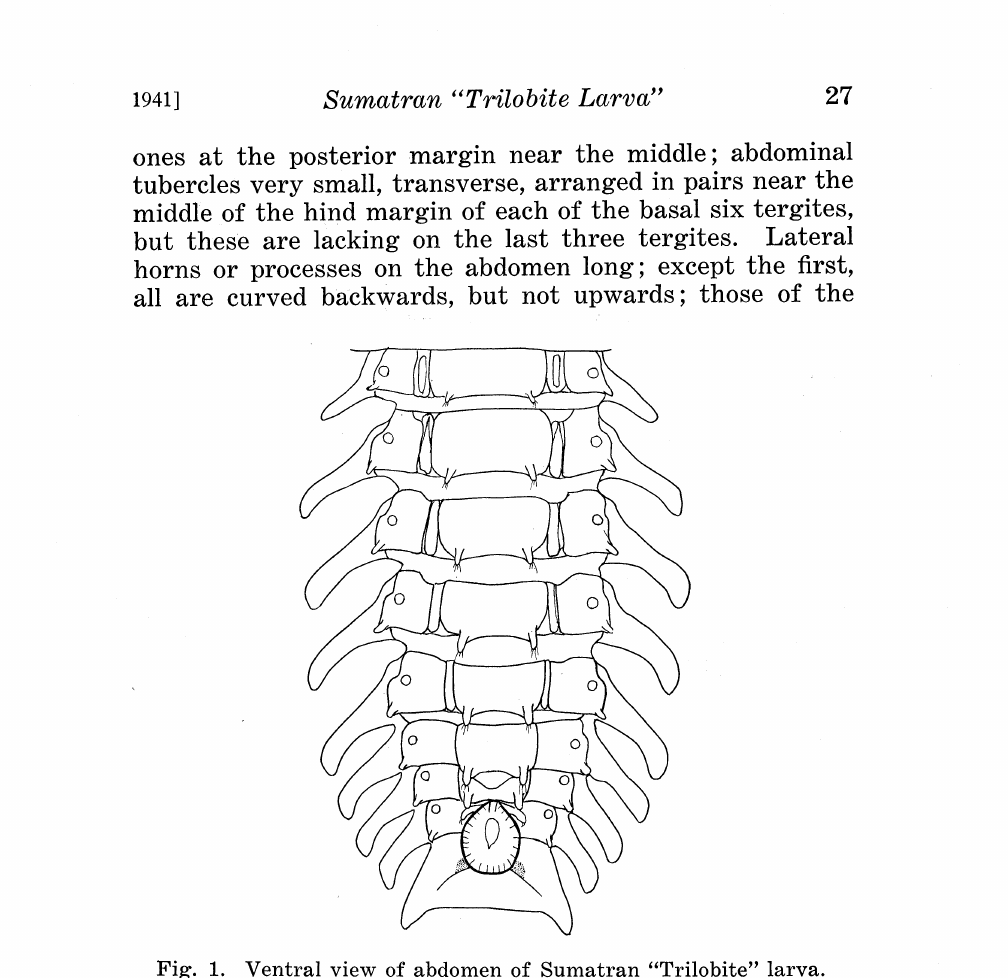
Fig. 1. Ventral view of abdomen of Sumatran "Trilobite"